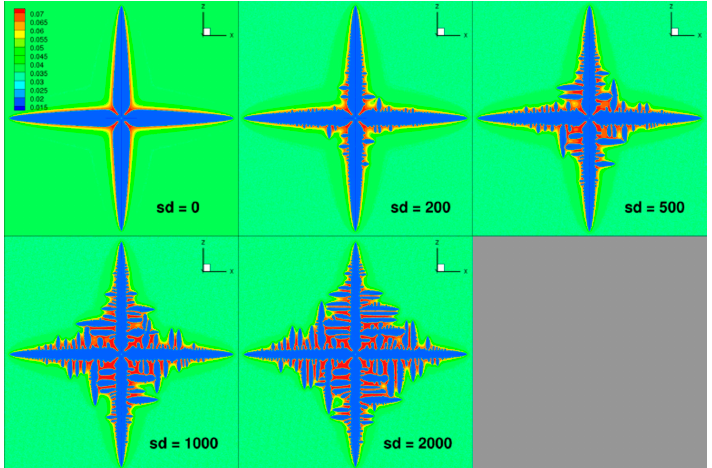
Figure 4. Effect of the magnitude of random noise on the isothermal solidification microstructure in 2D at 1617 K.